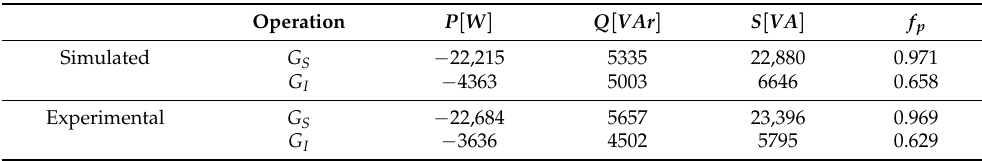
Table 7. Operation in G I and G S